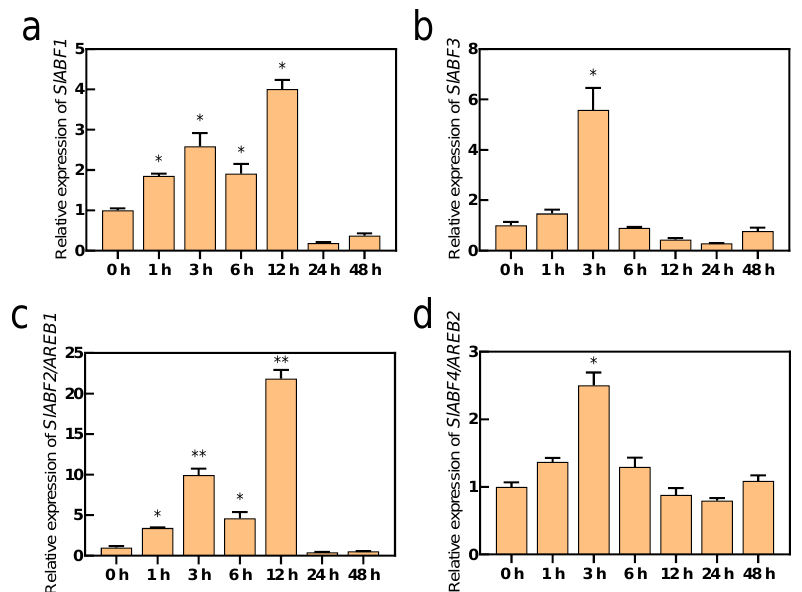
Figure 2. The expression of SlABF/AREB subfamily genes with ABA treatment. The wild-type tomato seedlings with fifth true leaves were treated with 100 µ M ABA for 0, 1, 3, 6, 12, 24 and 48 h. The expression of ( a ) SlABF1 , ( b ) SlABF3 , ( c ) SlABF2/AREB1 and ( d ) SlABF4/AREB2 genes was measured. SlACTIN was used as an internal control. The relative expression of genes was based on ABA treatment for 0 h. Values represent averages of four independent measurements, and error bars represent standard errors. Asterisks denote a significant difference compared with the control (* p < 0.05, ** p < 0.01).